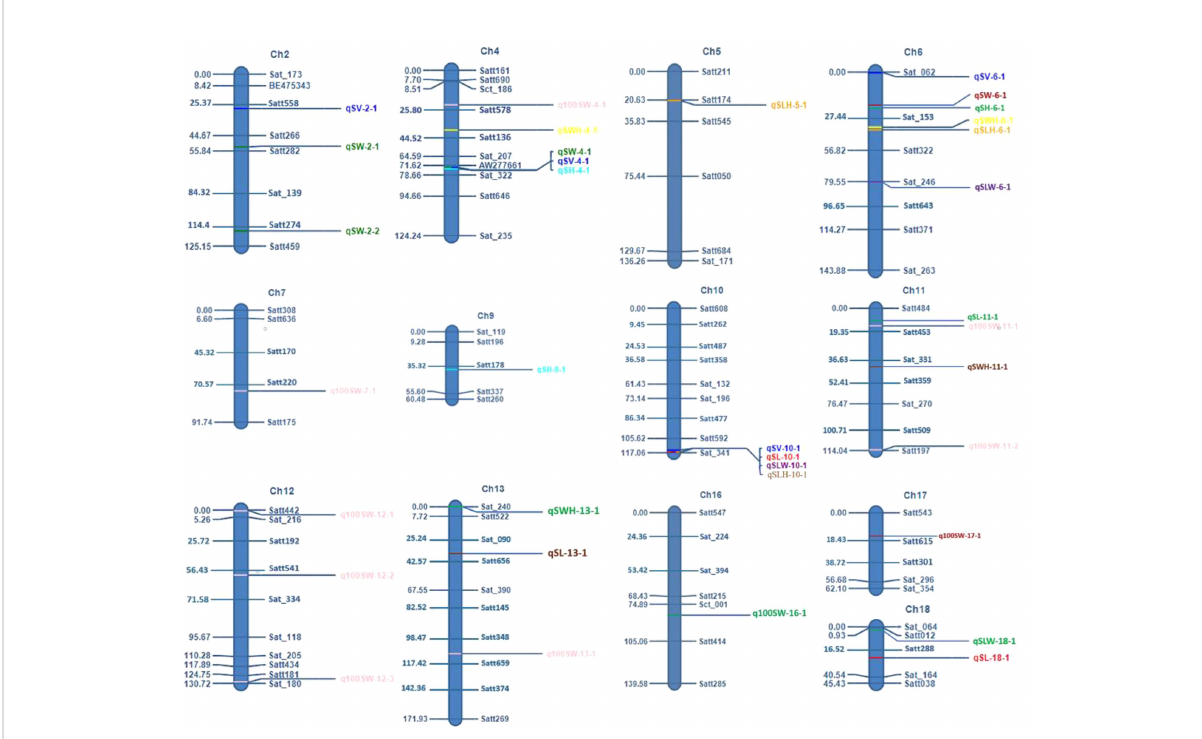
FIGURE 4 Mapping positions of various seed shape and 100 seed weight QTLs in this